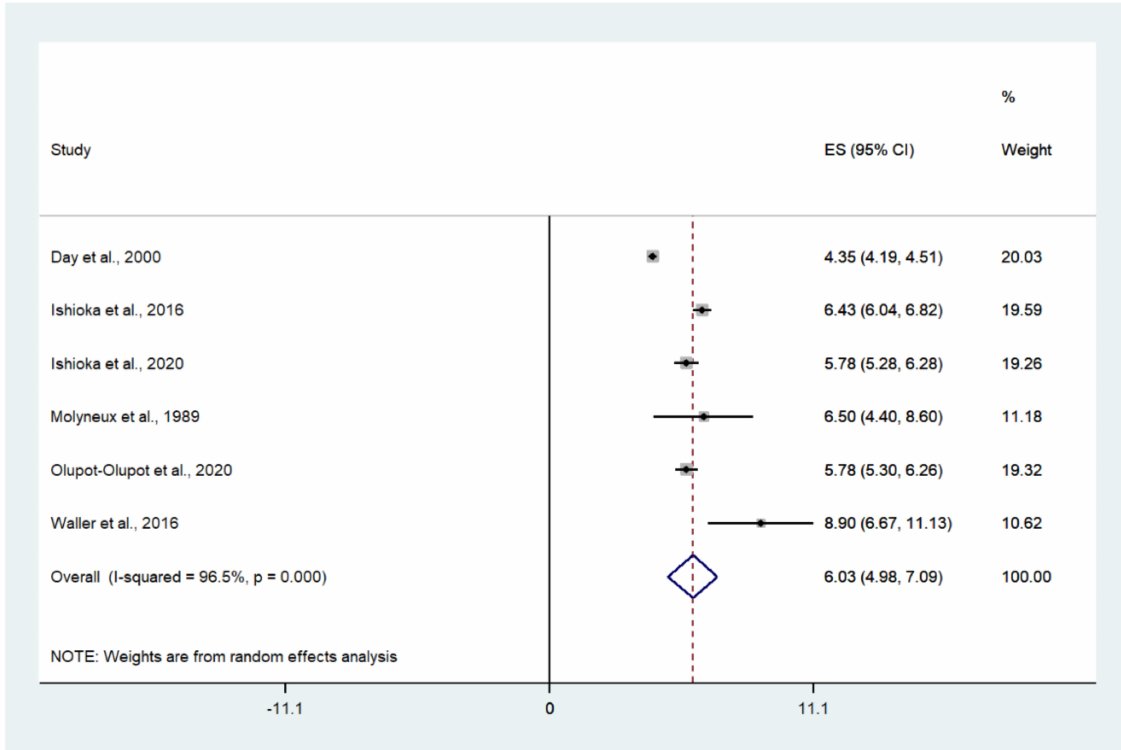
Figure 5. Mean lactate level in patients with severe malaria who died. Abbreviations: ES, estimated mean lactate; CI: confidence interval; NS, not